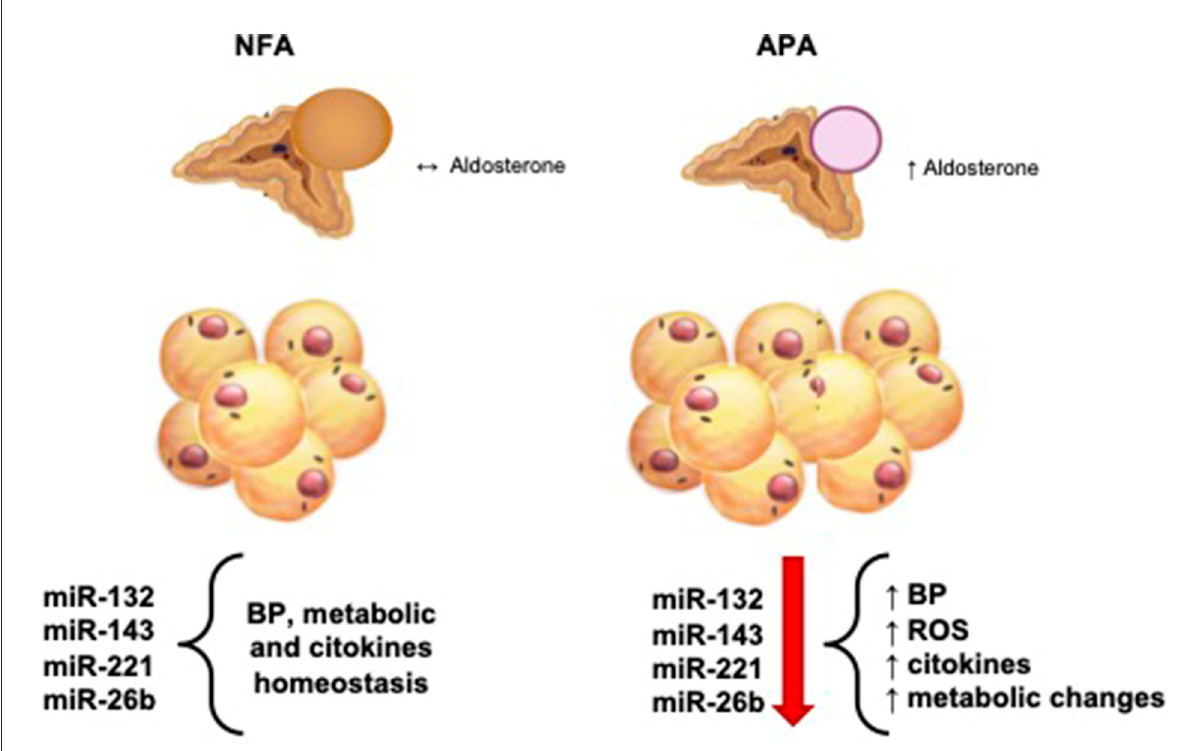
FIGURE3 Physiological and pathophysiological relationship between aldosterone production and hemodynamic, metabolic, and molecular balance. NFA, non-functional adrenal mass; APA, aldosterone-secreting adrenal adenoma; BP, blood pressure; ROS, reactive oxigene species.